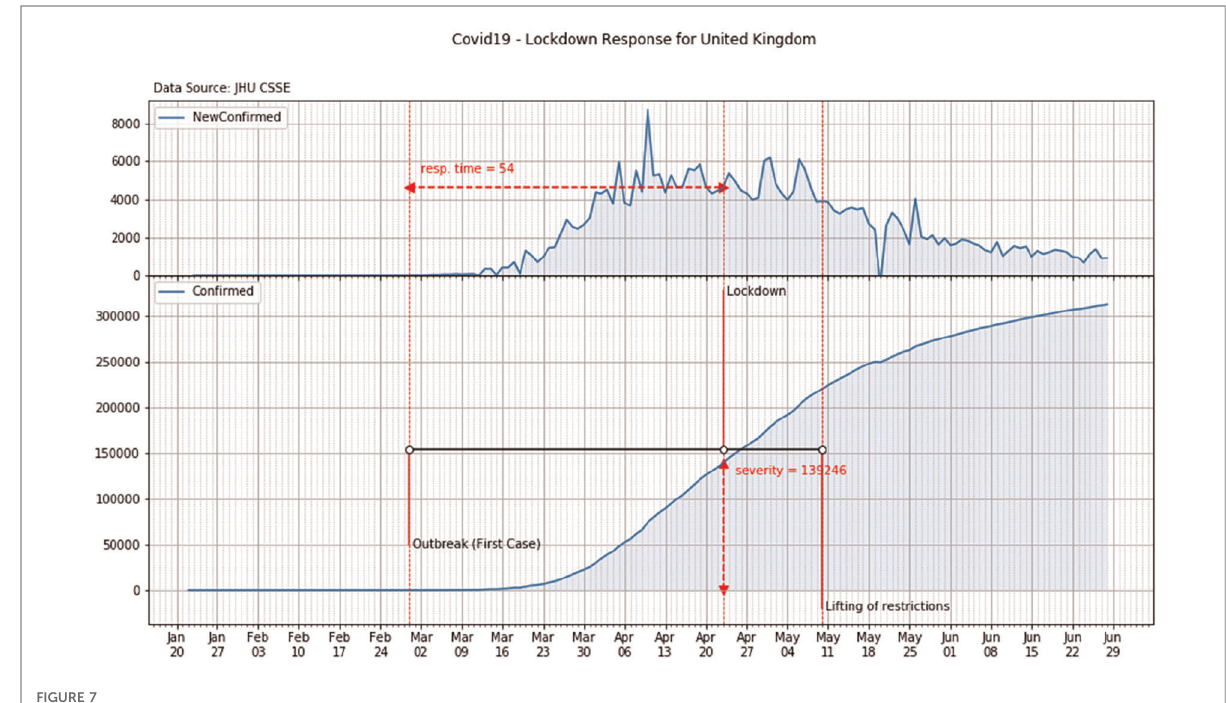
FIGURE 7 Response time and severity of the lockdown in United Kingdom.